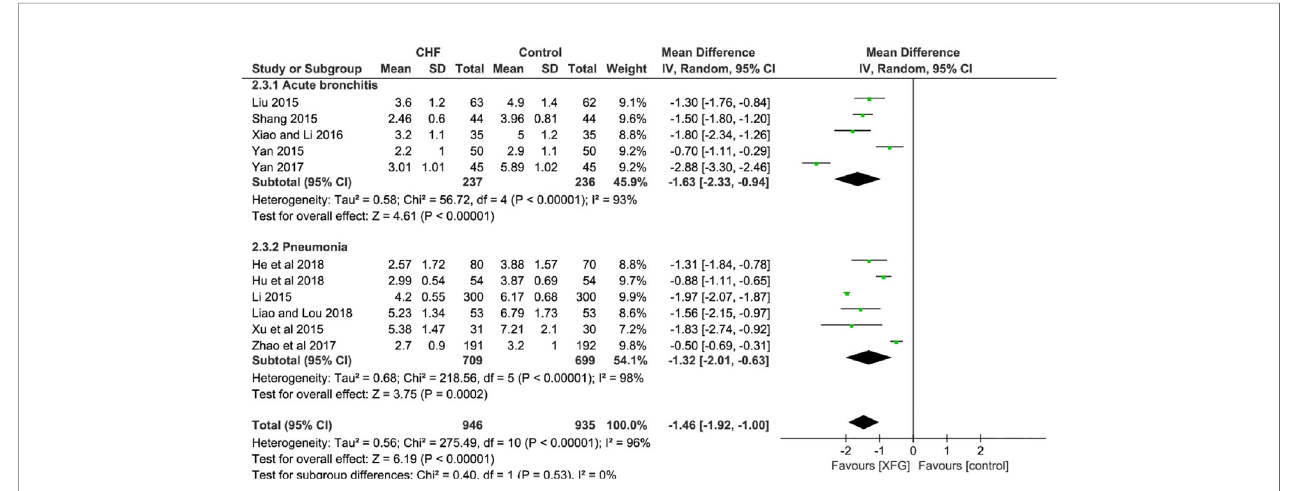
FIGURE 6 | Forest plot and subgroup analysis of the